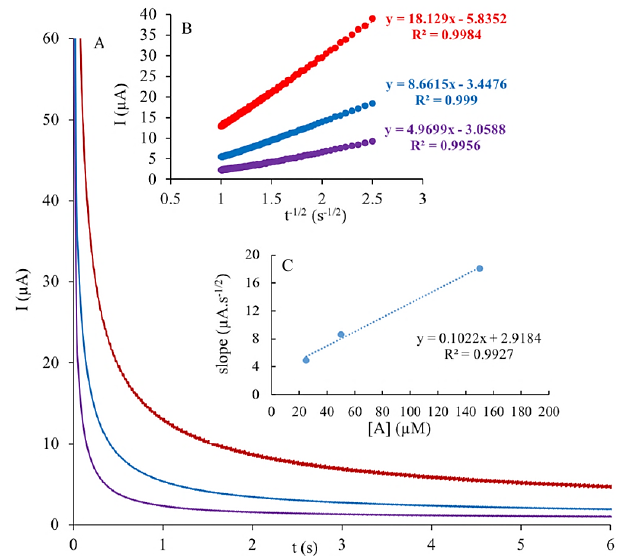
Figure 10. ( A ) Chronoamperograms of GCE/GO-MWCNT-CHT for varying concentrations of adenine ( A ): 25, 50, and 150 µ M in 0.2 M PBS (pH 7.0); ( B ) plots of anodic peak currents (I pa ) versus t − 1 / 2 ; ( C ) plot of the slope of the straight line versus concentration of A.